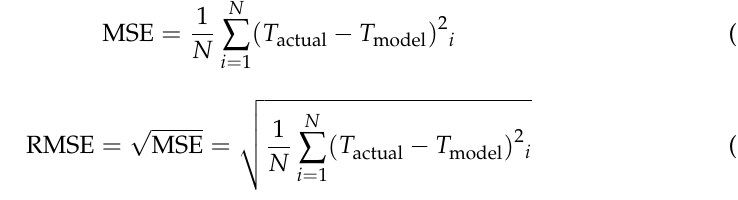
Table 3. Comparison of mean square errors along six cut-line in two methods. Vertical Cut-Lines